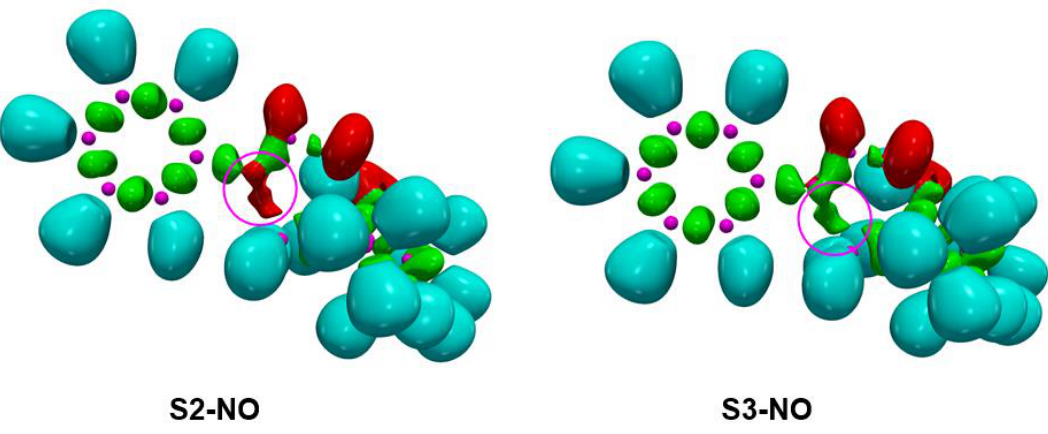
Figure 6. B3LYP/6-31G(d) ELF localisation domains, represented at an isosurface value of ELF = 0.75, of the structures S2-NO and S3-NO involved in the formation of the first C3 − C4 single bond along the 32CA reaction between of phenyl NO 4a and (R)-carvone 1 .